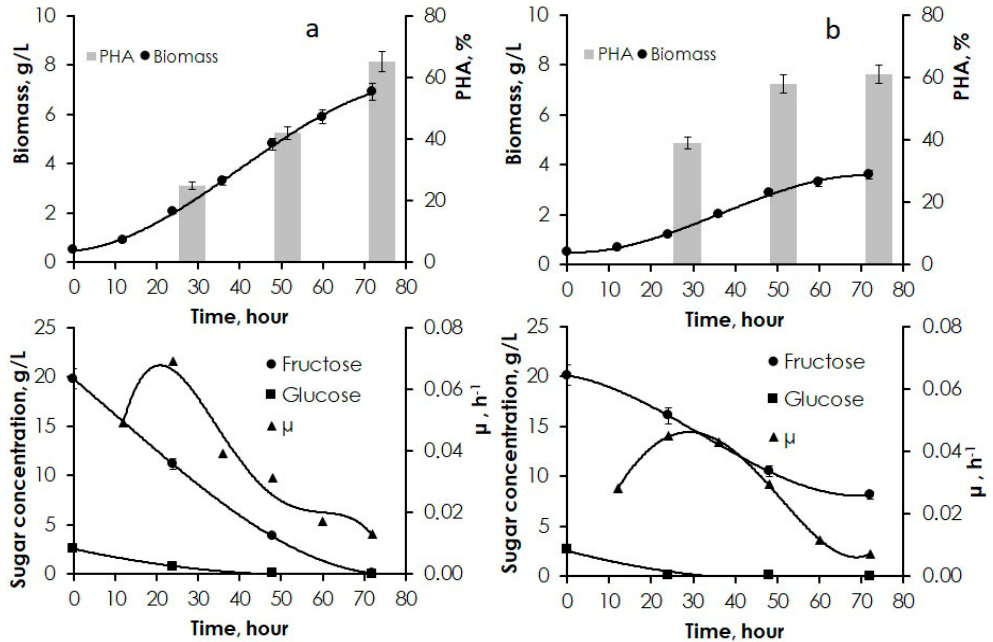
Figure 2. Parameters of cell growth and PHA synthesis achieved by C. necator B-10646 cultivated on JA tuber hydrolysates (growth curve, PHA content, consumption of carbohydrate substrates, specific growth rate): ( a ) aqueous extraction at 80 °C followed by acid hydrolysis at 60 °C, ( b ) simultaneous extraction and acid hydrolysis at 80 °C.